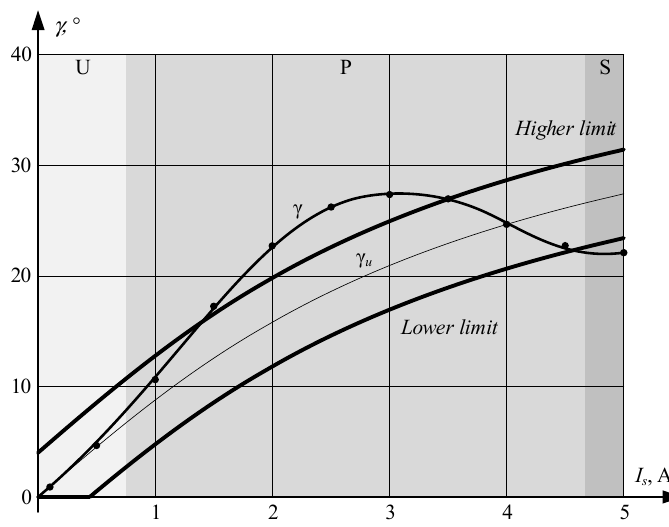
γ using rated MTPA curve with